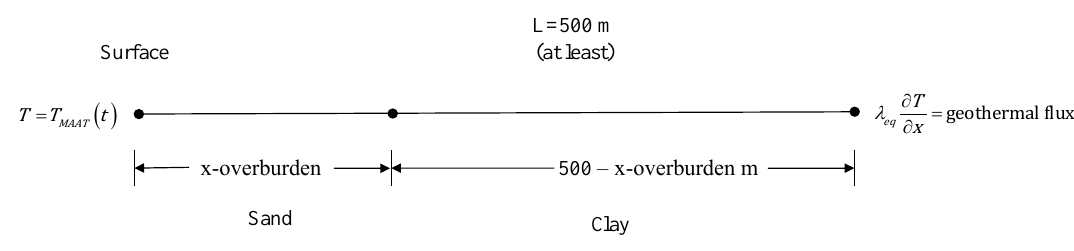
Figure 4. Model domain and boundary conditions.